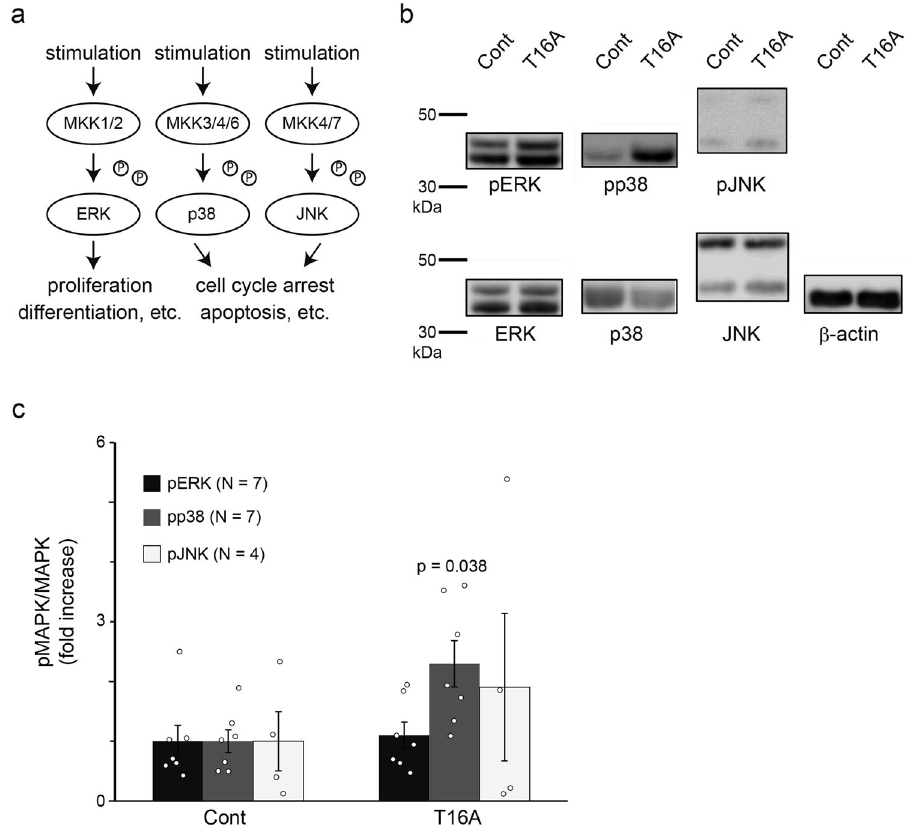
Fig. 8 Effects of an ANO1 inhibitor on MAP kinase phosphorylation. a Schematic representation of MAP kinase signaling. b Representative images of Western blotting for total MAP kinases and phosphorylated MAP kinases. Uncropped gel images are shown in Suppl. Fig. 11. c Quantitative analysis of Western blotting for phosphorylated/total MAP kinases. Data represent means ± SEM ( N = 7 for pERK and pp38, N = 4 for pJNK. Statistical signi fi cance was determined with a Mann – Whitney